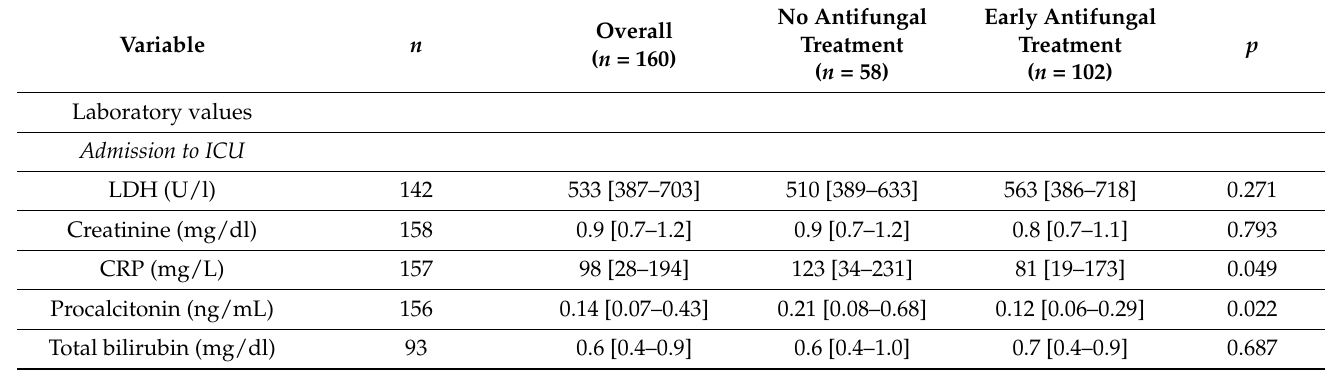
Table 2. Laboratory tests of patients on admission to the ICU and on the third day after